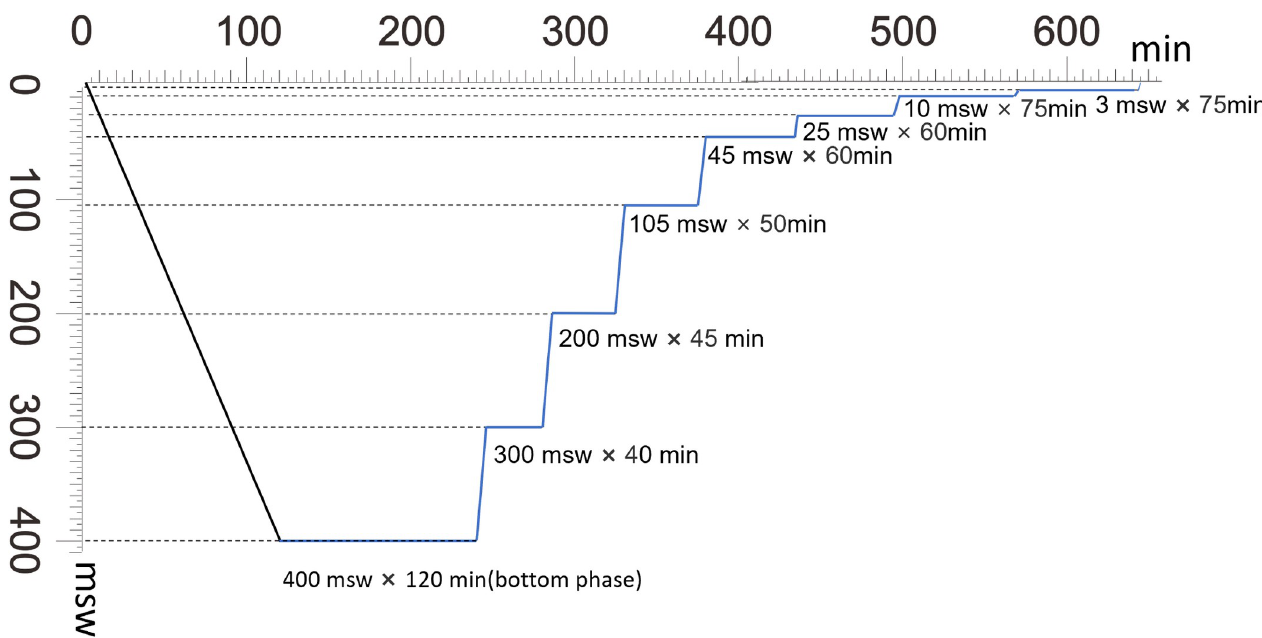
Fig 2. Illustrative timeline overview of the hyperbaric decompression of stimulated heliox saturation diving to 400 msw.